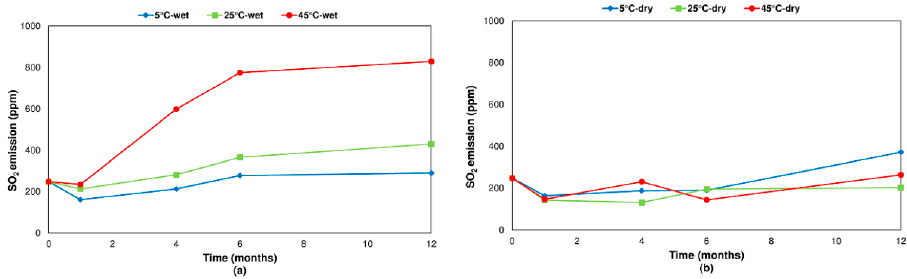
Figure 6. Sulfur dioxide emission area of the chalcopyrite composition at 900–1200 ° C in a ( a ) wet environment and ( b ) a dry environment .